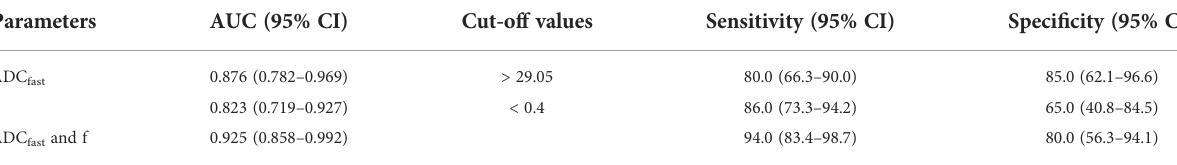
TABLE 4 Ef fi cacy of IVIM in the differential diagnosis of tuberculous spondylitis and spinal metastasis. Parameters